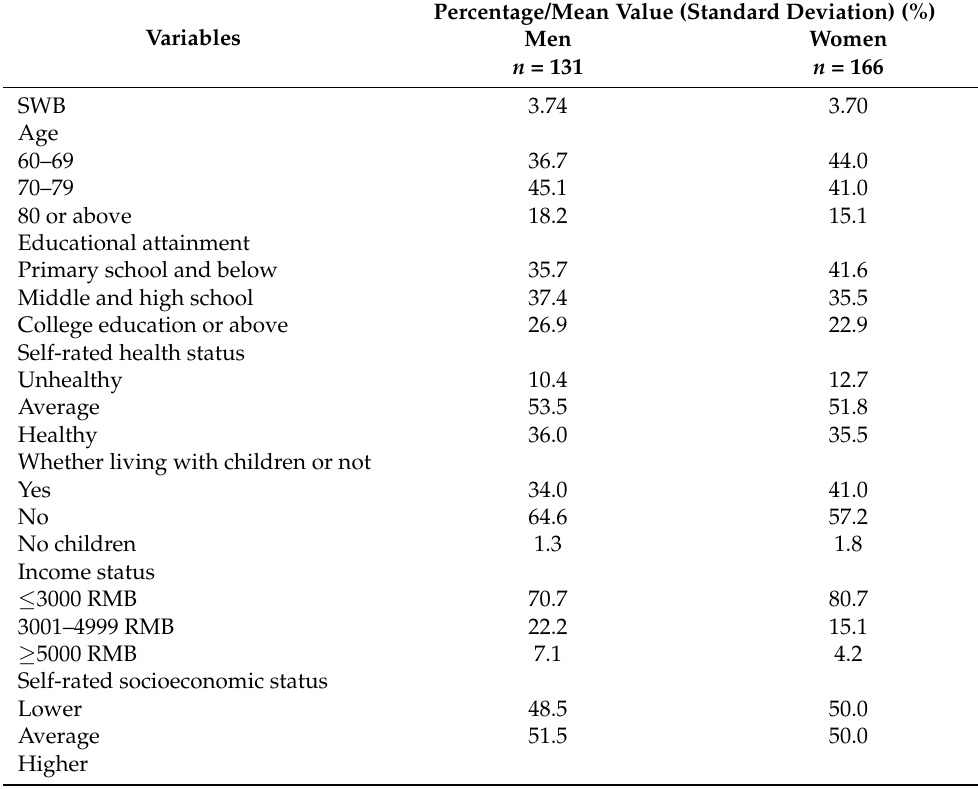
Table 1. Descriptive statistics of variables.